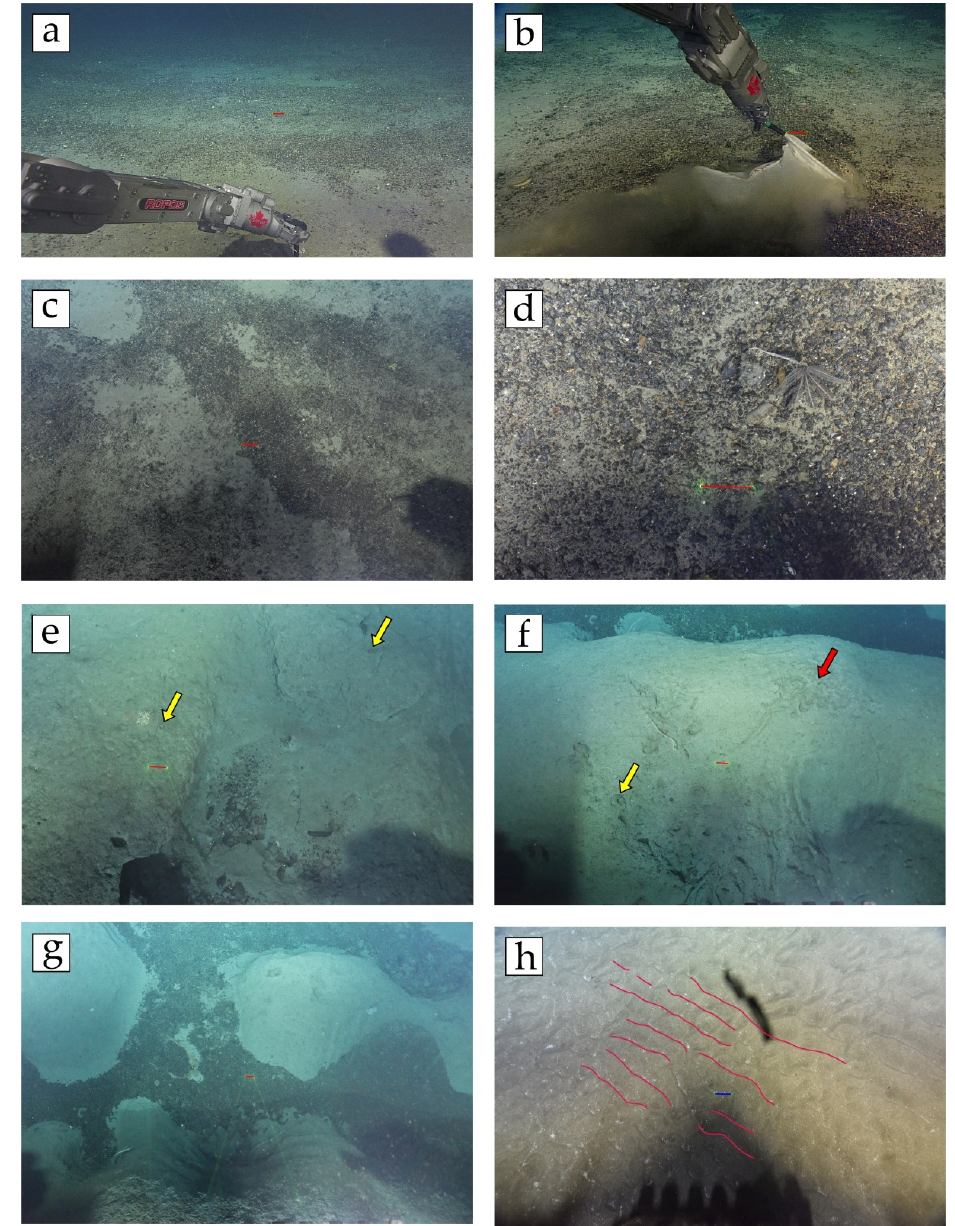
Figure 2. Seafloor images of sampling location. ( a ) Exposure of fragments of tubular carbonates on the seafloor. ( b ) The studied samples were collected using the manipulator arm of the ROV ROPOS. ( c , d ) Close-up of tubular carbonate fragments on the seafloor. ( e ) Some tubular carbonates were buried within sediment mounds (yellow arrows). ( f ) Numerous carbonate fragments in the depression between sediment mounds. ( g ) Suspected traces of biological activity on the surface of a sediment mound (red arrow), and a tubular carbonate buried within sediment (yellow arrow). ( h ) Current ripples in the study area. The widths of the colored short lines bounded by green dots are about ten centimeters.